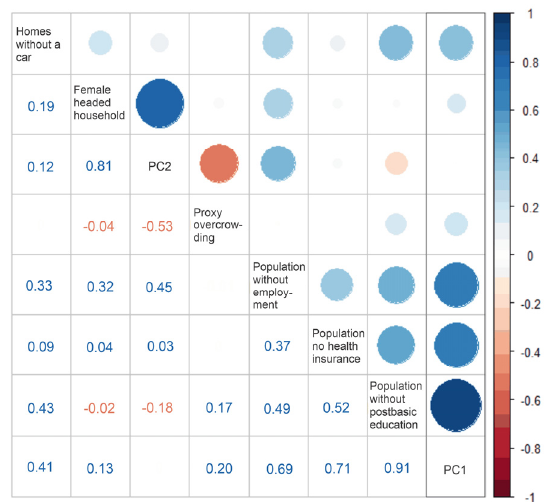
Figure 3. Component loads and correlation among the included variables for principal component 1 (PC1) and principal component 2 (PC2). The blue colors correspond to positive correlations; the red colors correspond to negative correlations. The color intensity and size of the circle are proportional to the component load.